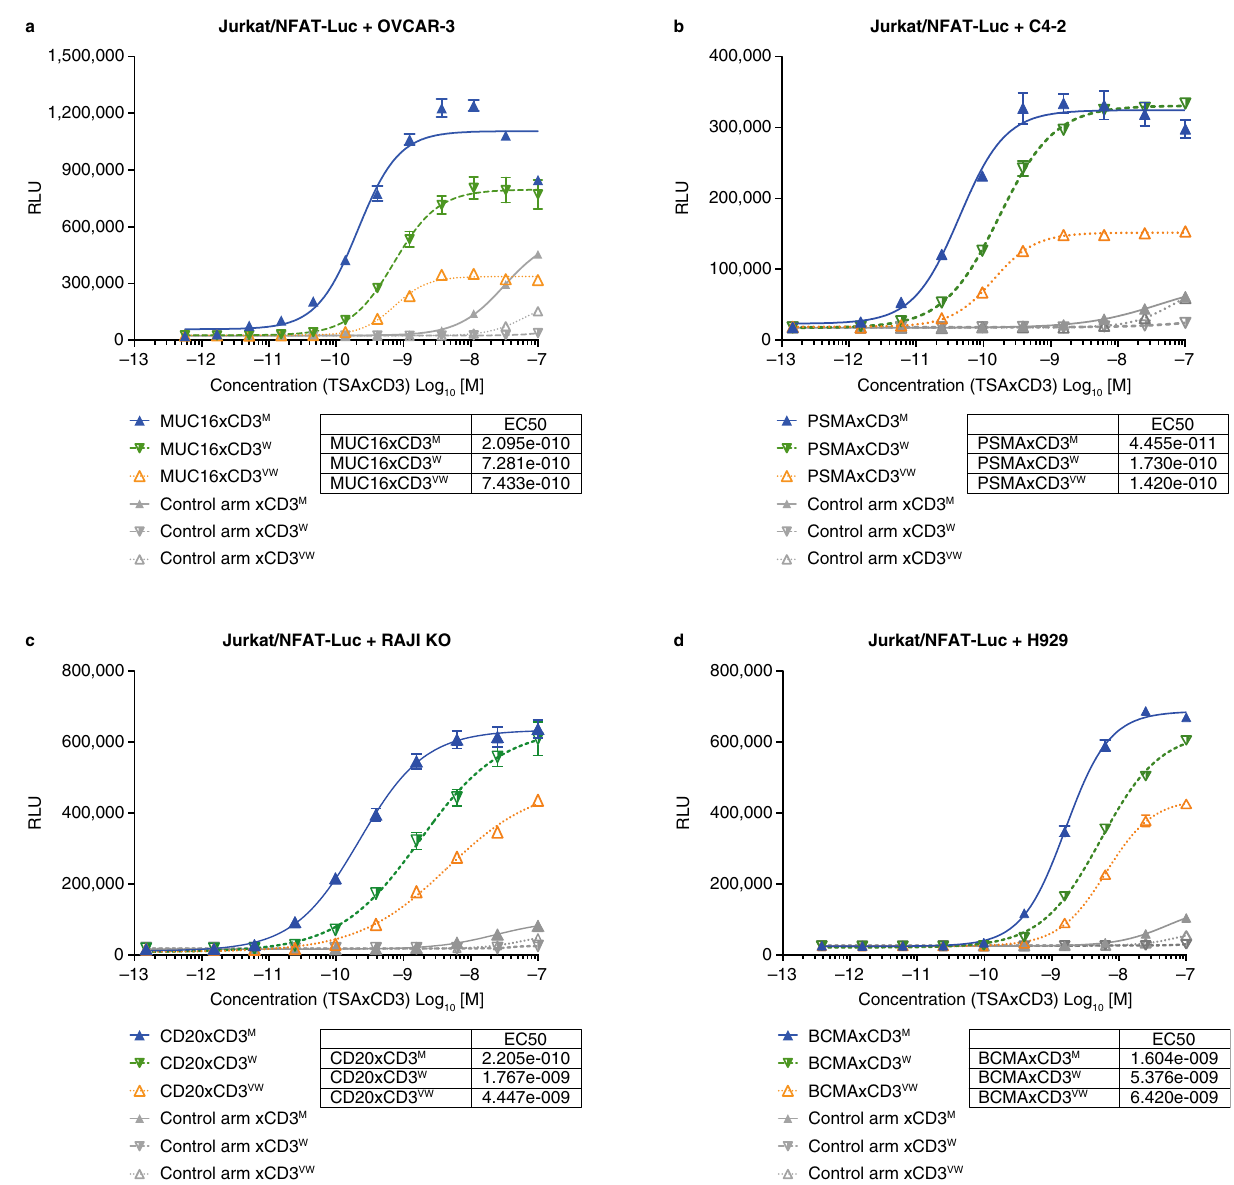
Figure 3. CD3-based bispecific antibodies induce in vitro activation of T cells in the presence of target cells, and activation is driven by the strength of the CD3 arm. ( a ) Jurkat/NFAT-luc cells were incubated with human MUC16-expressing OVCAR-3 cells and serial dilutions of MUC16xCD3 or CD3 bispecific control antibodies (gray symbols); ( b ) Jurkat/NFAT-luc cells were incubated with human PSMA-expressing C4-2 cells and serial dilutions of PSMAxCD3 or CD3 bispecific control antibodies (gray symbols); ( c ) Jurkat/NFAT- luc cells were incubated with human CD20-expressing RAJI-KO/CD80/CD86 cells and serial dilutions of CD20xCD3 or CD3-bispecific control antibodies (gray symbols); ( d ) Jurkat/NFAT-luc cells were incubated with human BCMA-expressing H929 cells and serial dilutions of BCMAxCD3 or CD3-bispecific control antibodies (gray symbols) (data in replicates of 2 or 3). BCMA B-cell maturation antigen; EC50 half maximal effective concentration; KO knock-out; luc luciferase; m moderate; MUC16 Mucin-16 for ovarian cancer; PBMC peripheral blood mononuclear cell; PSMA prostate specific membrane antigen; RLU relative luciferase unit ; TSA tumor-cell-specific-antigen; vw very weak; w observed in control conditions where human CD3-mediated NFAT signaling was monitored in the absence of tumor antigen expression (Supplementary Fig. S4). The cytotoxic potency of the TSAxCD3 bsAbs with differing CD3 affinities was assessed using a flow cytom- etry-based cytotoxicity assay 17 . BsAbs engineered to bind to MUC16, PSMA, or BCMA-expressing cells were evaluated for the ability to kill OVCAR-3, C4-2, or MOLP-8 cells, respectively. For each set of bsAbs, the tumor antigen targeting arms were identical for the studied target antigen but possessed a range of affinity to CD3 in their T-cell engaging arms.